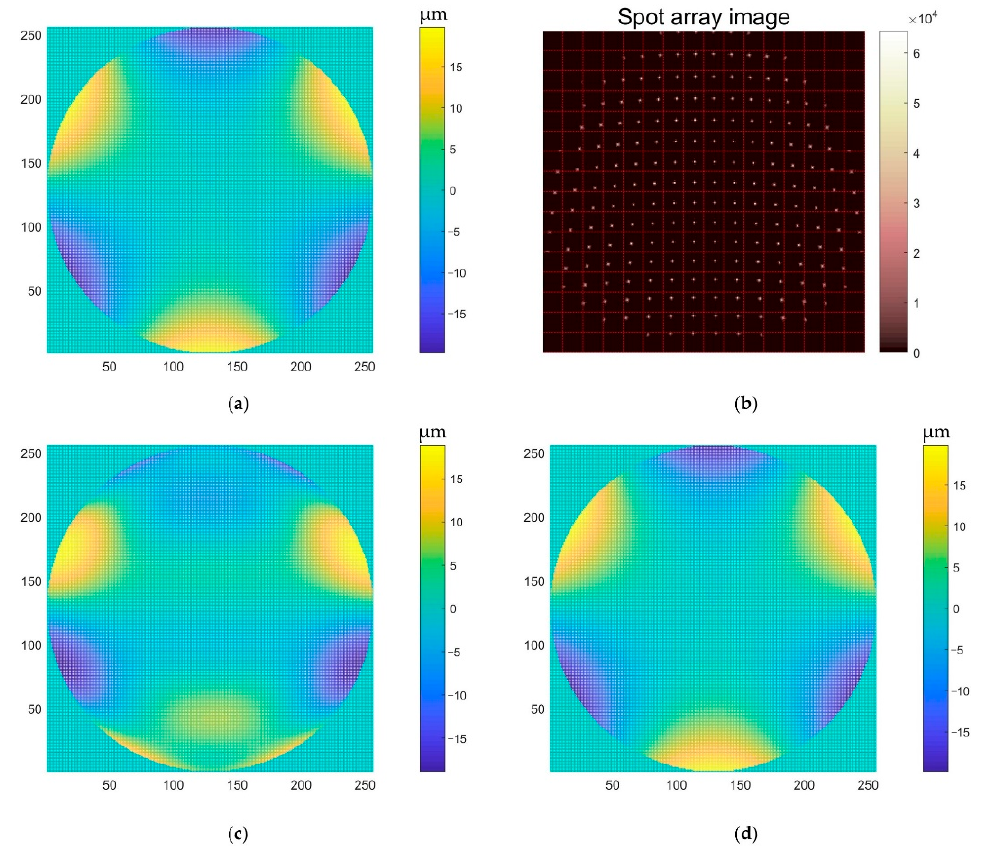
Figure 8. Z − 3 3 ( a ) Reference wavefront; ( b ) spot array; ( c ) wavefront reconstructed with the classical algorithm; ( d ) wavefront reconstructed with our